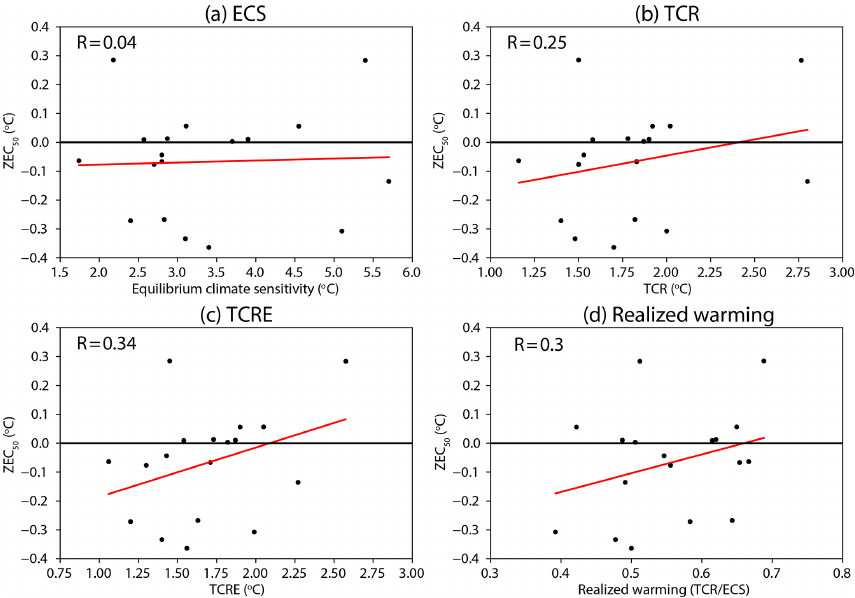
Figure 11. Relationship between ECS (a) , TCR (b) , TCRE (c) , realized warming, and (d) ZEC 50 . The line of best fit is shown in red. Correlation coefficients are displayed in each